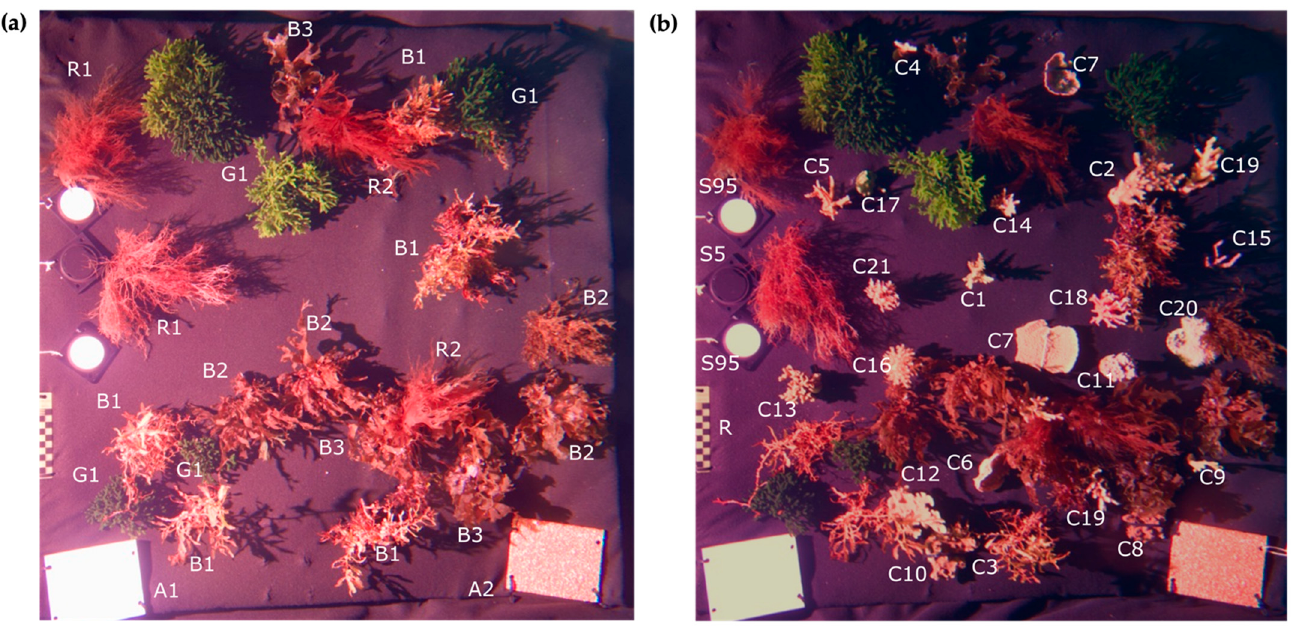
Figure 2. Macroalgae and coral imaging substrates arrangement prior to imaging tests where ( a ) macroalgae-only scene to left and ( b ) mixed macroalgae-coral scene to right. Shown are Green: (G1) Codium sp.; Brown: (B1) Sargassum sp.; (B2) Dictyota sp.; (B3) Padina sp.; Red: (R1) Grateloupia sp.;